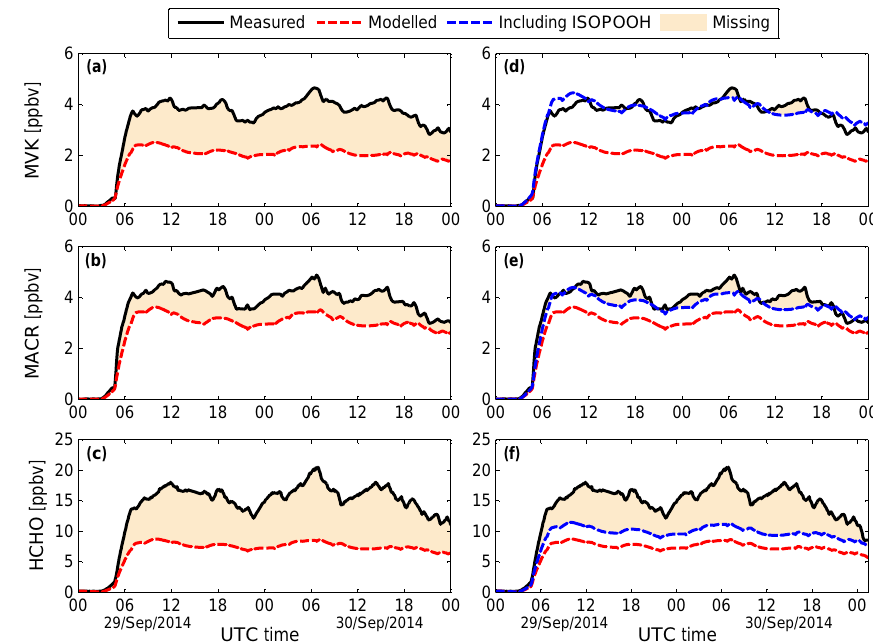
Figure 3. Measured MVK, MACR, and formaldehyde concentrations compared to model predictions. Panels (a) , (b) and (c) show MVK, MACR, and HCHO in comparison to the model predictions, respectively. Modeled concentrations are up to a factor of 2 lower. Panels (d) , (e) , and (f) show the comparison to the model prediction after the inclusion of the respective ISOPOOH isomer decomposition. Inclusion of ISOPOOH conversion resolves the discrepancy for MVK and MACR. Dashed lines correspond to model simulations.